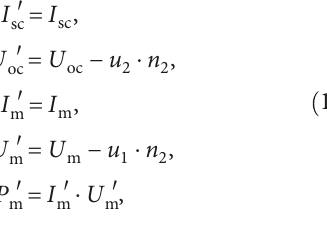
Table 2: Setting of simulation conditions. Solar irradiation Solar irradiation Module intensity of the intensity of the Type of temperature shaded portion unshaded portion shading ( ° C) (W/m 2 ) (W/m 2 ) Shadow 150 1000 25 shading Cover 0 1000 25 shading The irradiation intensity of the shadowed photovoltaic cells is set at 15% of the irradiation intensity absorbed by the unshadowed modules. The solar irradiation intensity of cover is set at zero. Temperature is 25 °